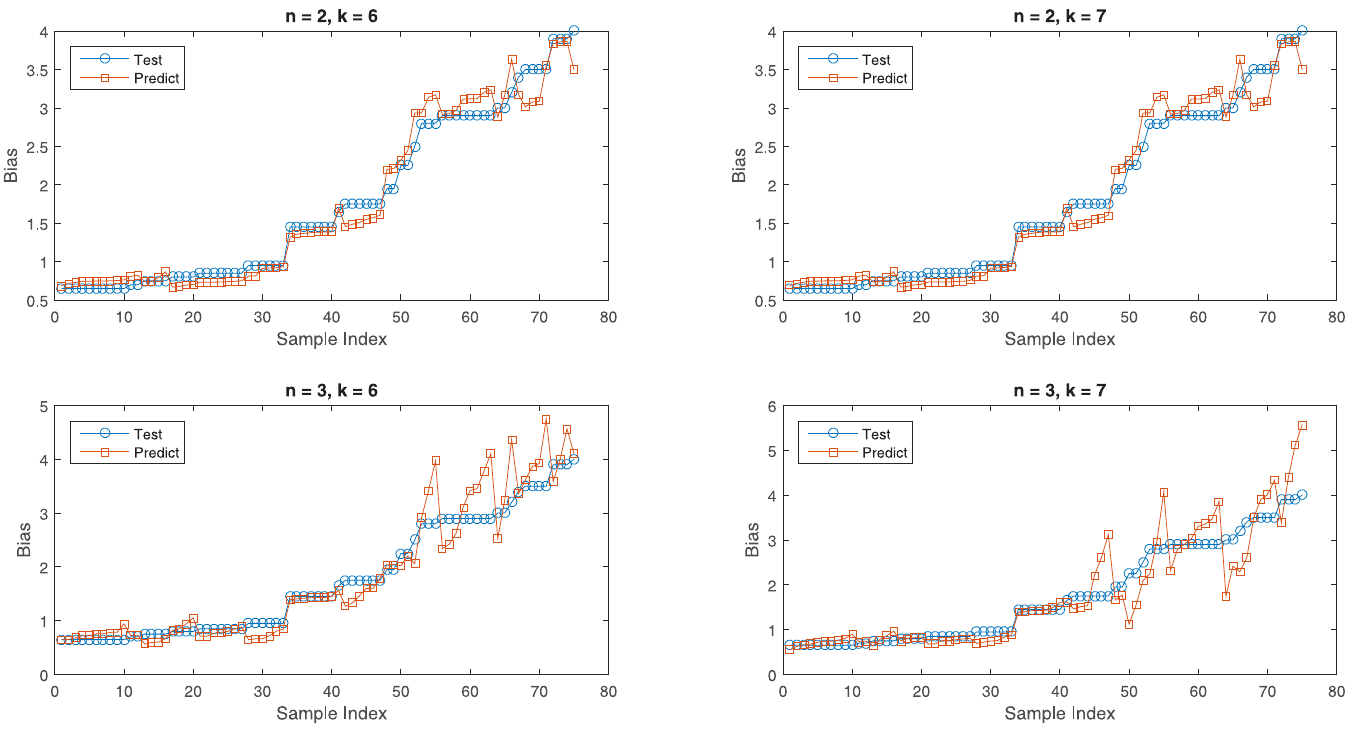
Fig 3. Actual and predicted bias values for polynomial